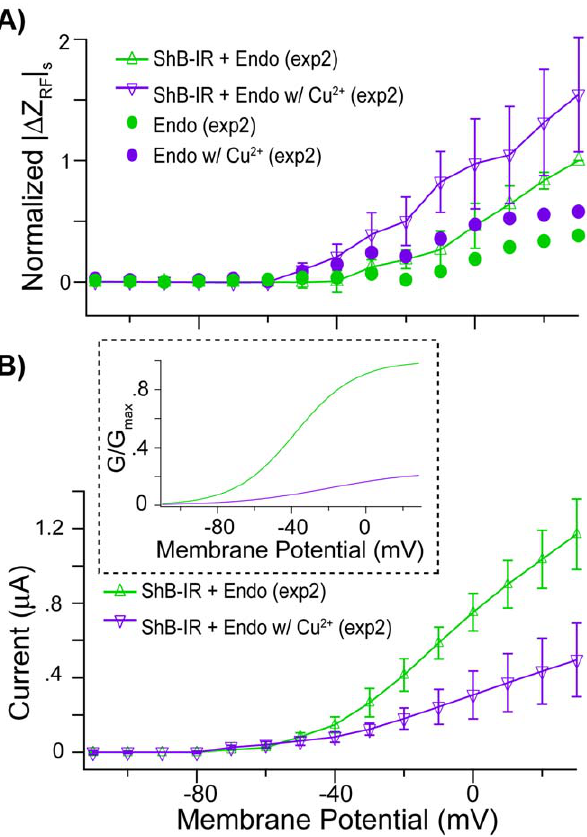
Figure 4. Copper treatment and steady-state Sh B-IR RF response. A) Voltage-dependent differences in | D Z RF | s were observed between Shaker expressing oocytes (‘‘ Sh B-IR + Endo’’, green line) and the same cells exposed to , 120 m M Cu 2 + (purple line). A similar effect was apparent, albeit to a lesser extent, for control cells before (‘‘Endo’’, green markers)/after Cu 2 + treatment (purple markers). Error bars denote + / 2 standard errors of the mean (SEM). B) Even though RF charge displacements increased in Cu 2 + -exposed Sh B-IR expressing oocytes, TEVC whole-cell current decreased showing that Cu 2 + successfully blocked the channels (channel conductance shown as inset).